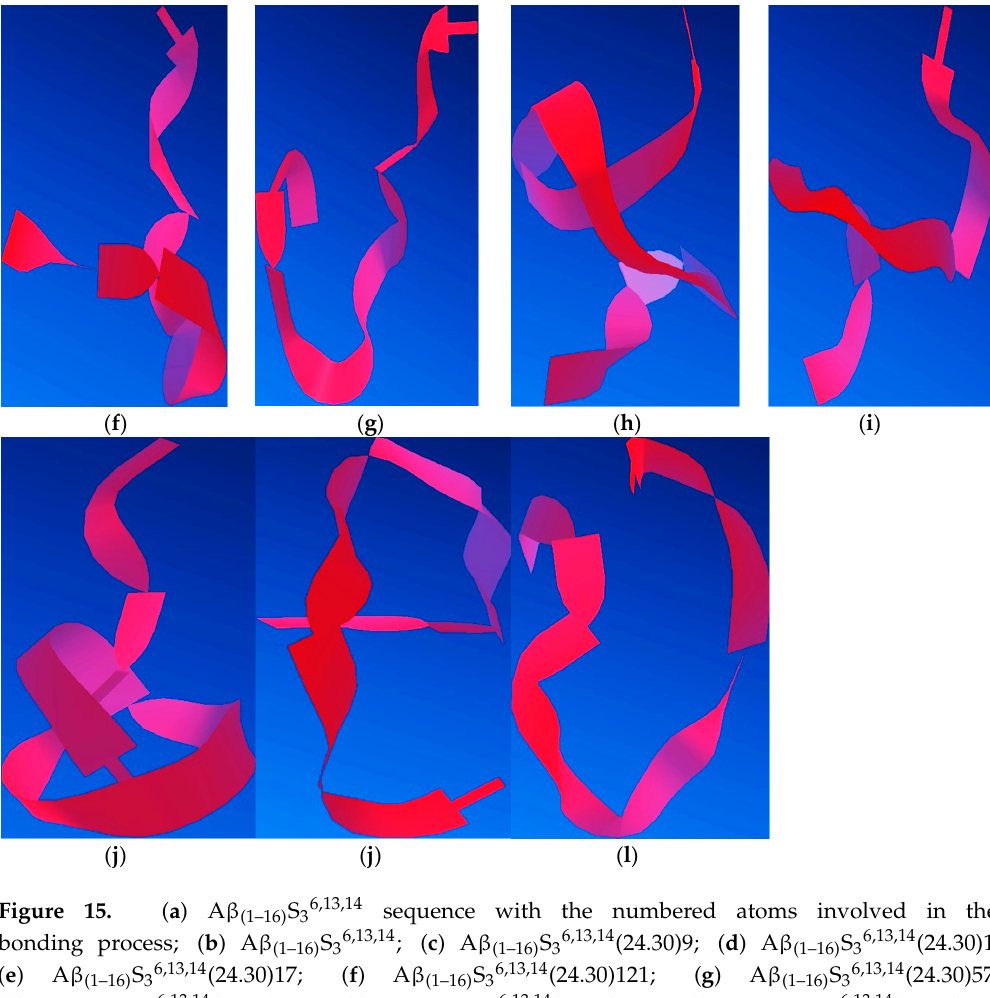
Molecular modelling indicated that the site of aluminium binding migrates toward the C- terminus of the peptide, and the peptide backbone tends to adopt a rather β -sheet conformation, thus reducing the proportion of α -helix conformers that induced the specific elasticity of the peptide.